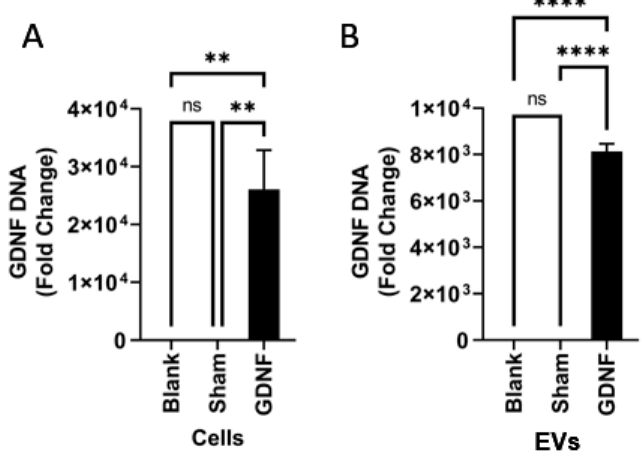
Figure 2. Characterization of genetic content of GDNF-transfected parent macrophages and released EV-GDNF by quantitative qPCR. Macrophages were transfected with GDNF-encoding p DNA by electroporation, and the levels of GDNF-DNA in the cells ( A ) and EVs released by these cells ( B ) were assessed. A significant amount of GDNF-DNA was detected in parent cells, as well as in the EVs. Statistical significance was assessed by one-way ANOVA corrected for multiple comparisons using the FDR. ** p < 0.01, or **** p < 0.0001.